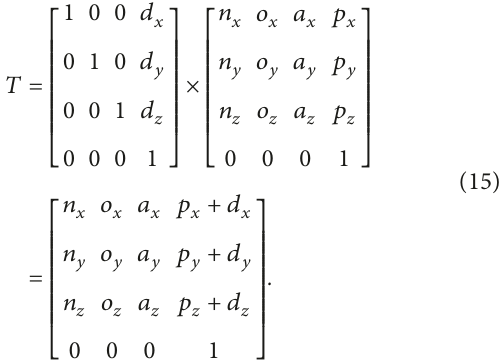
Figure 9: Relationship between the